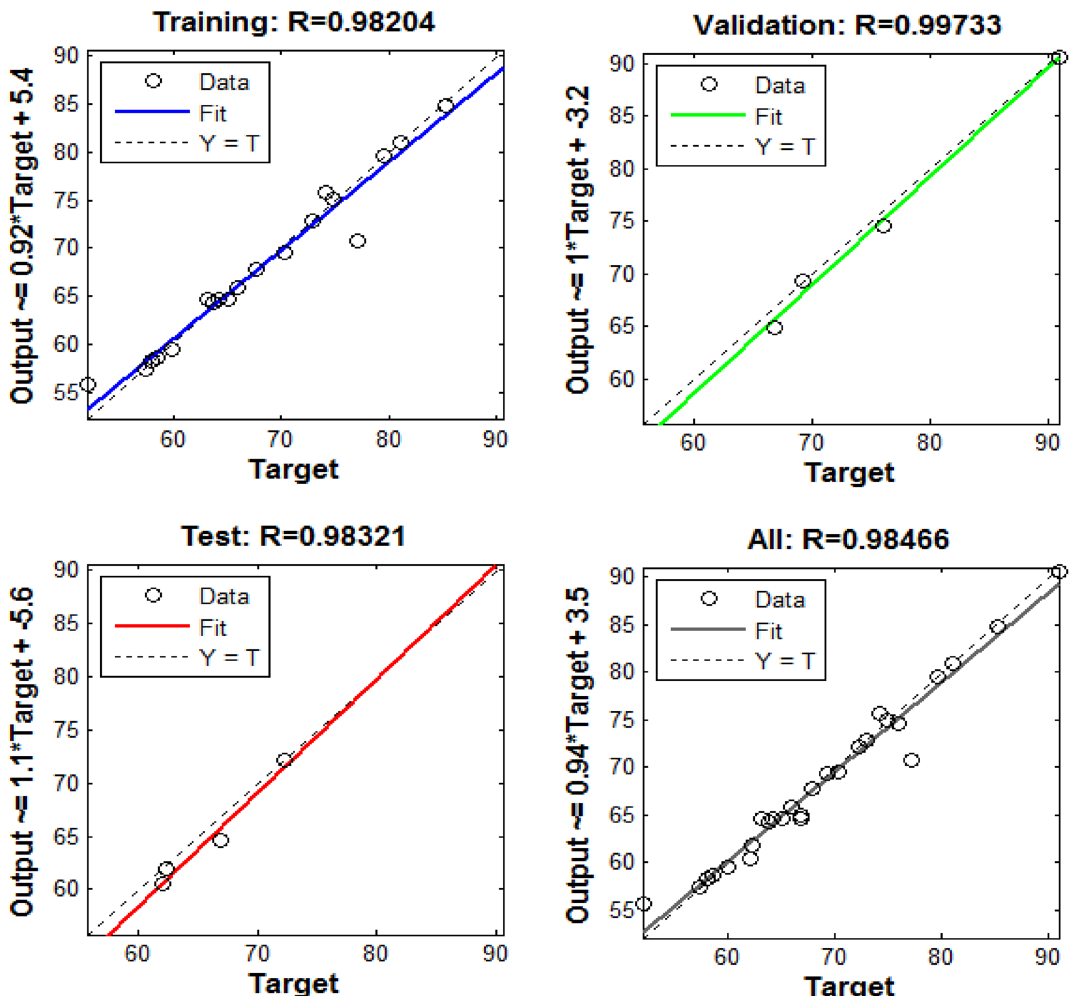
Figure 5. Regression plots for training, testing, and validation, and all data of the three-layer ANN model.